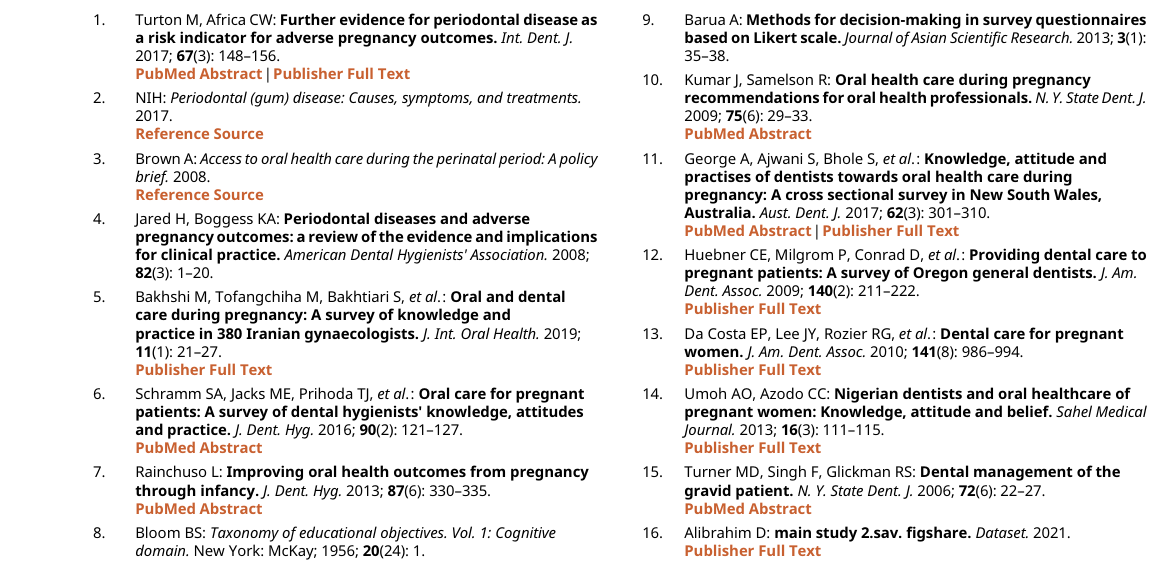
This project contains the following extended